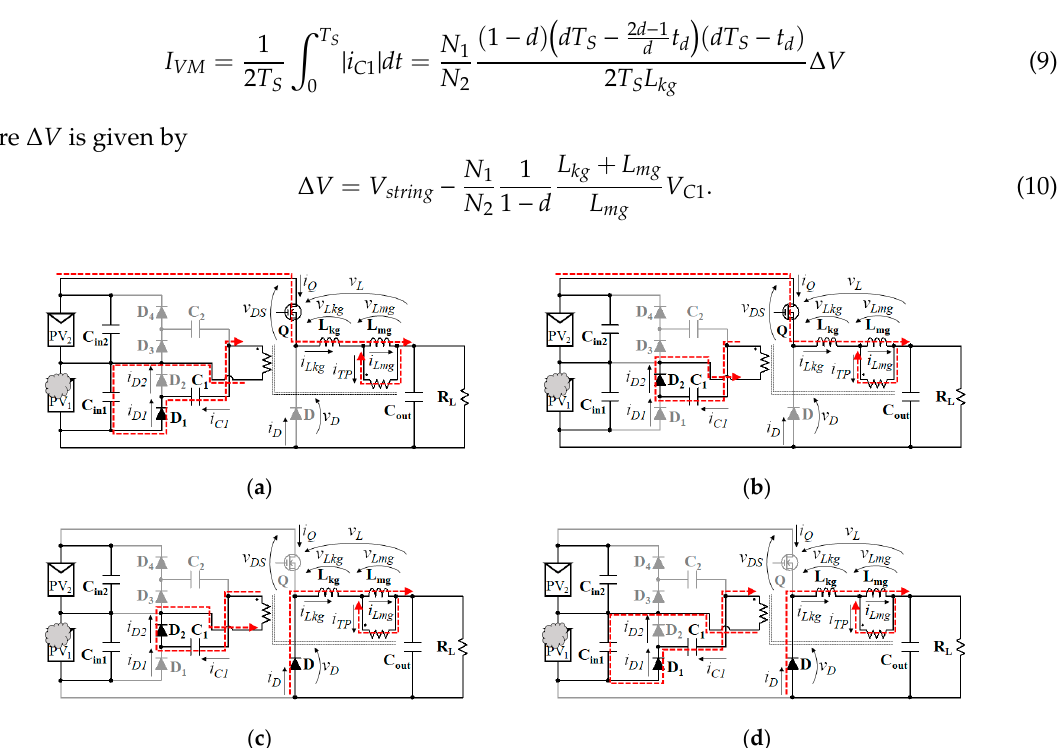
Figure 10. Current flow paths in ( a ) Mode 1, ( b ) Mode 2, ( c ) Mode 3, and ( d ) Mode 4.